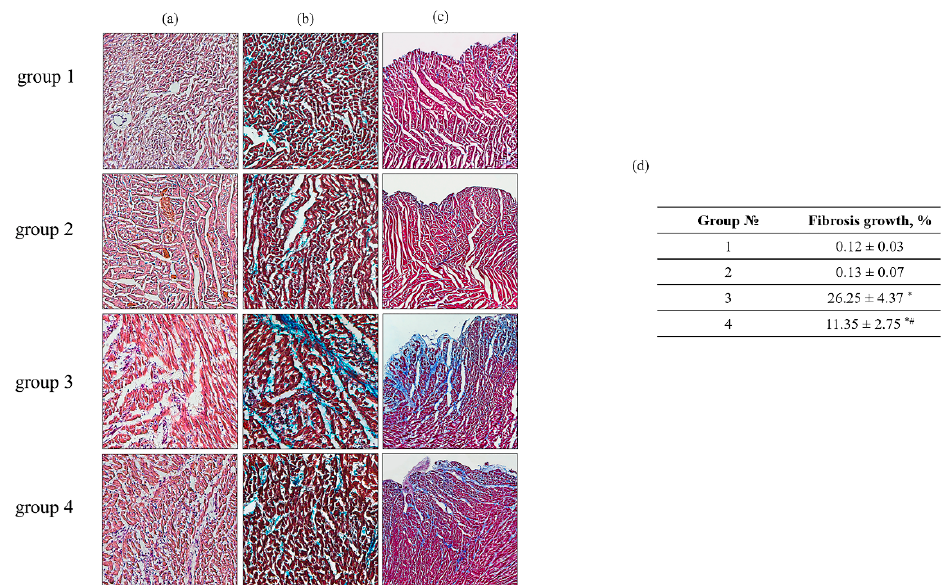
Figure 2. Histological samples of heart ventricles in rats of the control and experimental groups. ( a )—H&E (cell nuclei are in blue, erythrocytes are in red, muscle tissue is in pink); ( b )—Masson’s trichrome staining (collagen/fibrosis is stained with blue, muscle and other tissues are stained with red, and cell nuclei are stained with brown); ( c )—Lillie’s trichrome staining (collagen/fibrosis is shown in blue; muscle and other tissues are in red-brown; cell nuclei are in brown-black); ( d )—a table reflecting fibrosis growth in the tissue of the left ventricle from each group of rats. Data are presented as means ± SDs of five independent experiments. The numbers on the graphs represent the percentage of fibrous growth in the tissues of each group. * p < 0.05 indicates a significant difference in the tissue damage relative to the control (group 1). # p < 0.05 compared to RHM isolated from ISO-injected rats (group 3). The statistical significance of the differences between the pairs of the mean values was evaluated using an ANOVA type 2 (Student–Newman–Keuls) test.